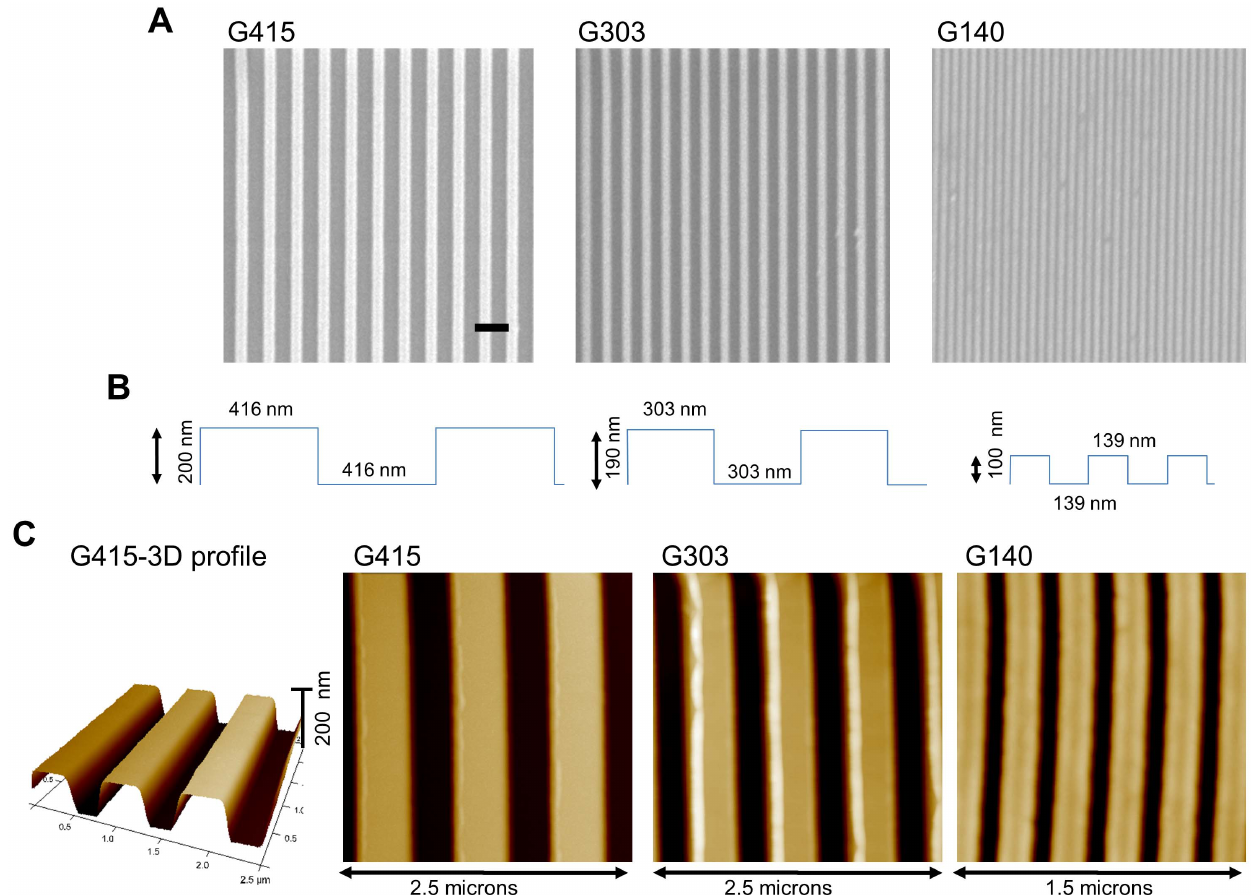
Figure 2. Capillary assisted UV lithography produced thin film substrates with nanotopography. (A) Scanning electron microscopy (SEM) was utilized to image nanoPMMA films. Micrographs confirm the presence of nanoscale dimensions in all three of the different film types utilized in this study: G415, G303, and G140 (scale bar =1 micron). (B) Illustrations show the approximate dimensions (height and width) of the PMMA films. (C) Atomic force microscopy was used to confirm that PMMA films had the expected nanotopographic features (see Table 1 for